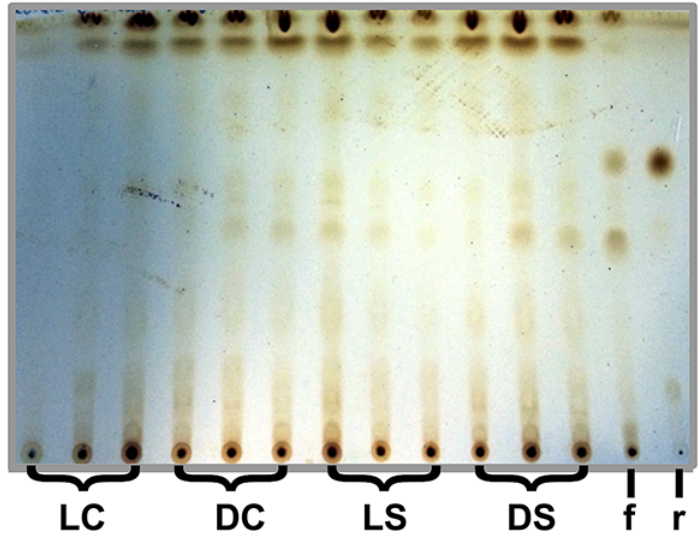
Fig. 5 Thin layer chromatography of secondary metabolites extracted from C. annuum ‘Serrano’ samples. Cell suspensions of WT cells were grown in liquid medium under a 16/8-h light cycle (LC) or in the dark (DC), or in medium with 40 mM NaCl under a 16/8-h light cycle (LS) or with NaCl 40 mM and in the dark (DS). The extract from the natural green fruit (f) and a standard of purified capsaicin (r) is also shown. Arrows show the positions expected for capsaicin and